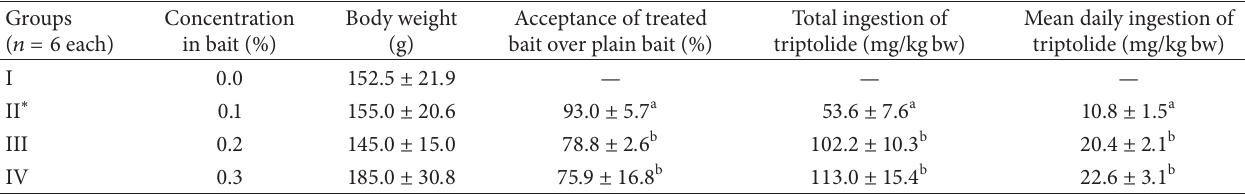
Table 1: Acceptance of bait containing different concentrations of triptolide fed to male R. rattus in laboratory for 5 days in no-choice feeding test.